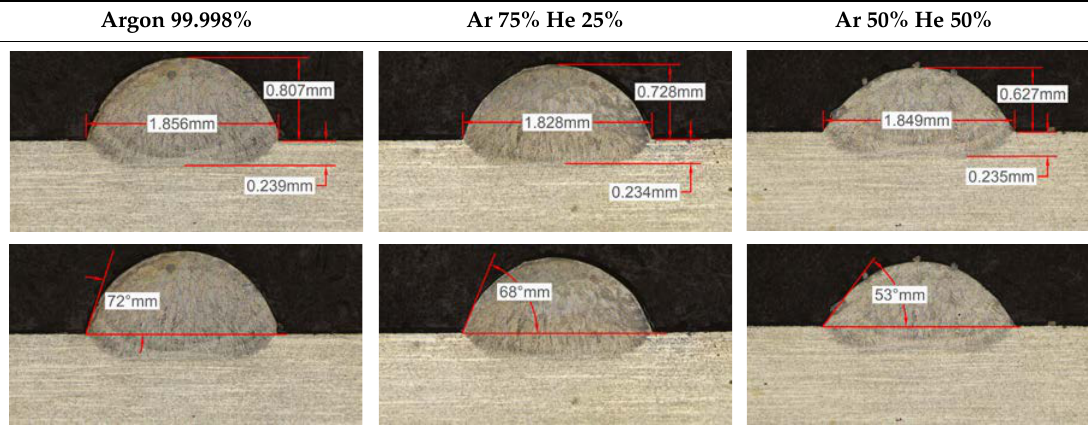
Table 9. Measurements for different gases at 800 W.